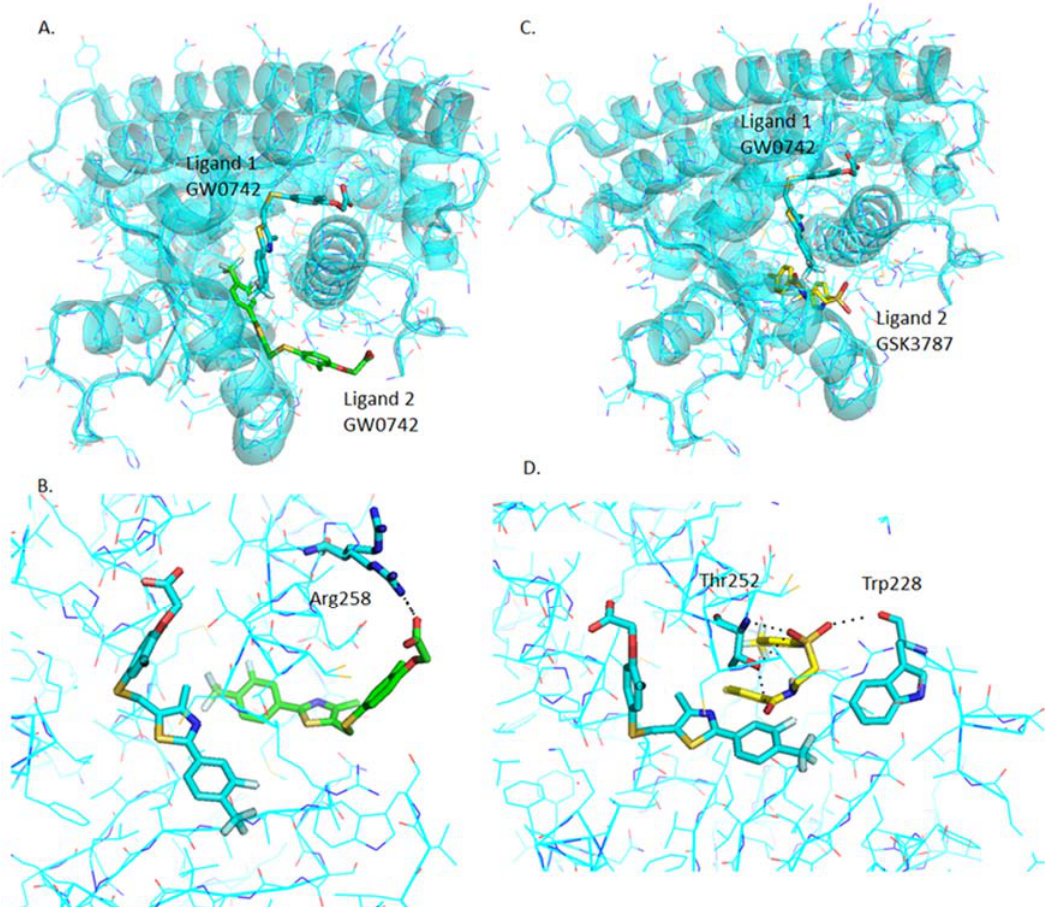
Figure 7. Analysis of GW0742 and GSK3787 docked into PPAR β / δ + GW0742. A second molecule of GW0742 ( A , B ) or GSK3787 ( C , D ) was docked into the LBD of PPAR β / δ containing one molecule of GW0742. ( A ) Representation of how two GW0742 molecules bind into the PPAR β / δ binding pocket at same time. ( B ) Detail of the amino acids interacting with the second molecule of GW0742. ( C ) Representation of how one molecule of GW0742 first and then one molecule of GSK3787 bind into the PPAR β / δ binding pocket at same time. ( D ) Detail of the amino acids interacting with the second molecule of GSK3787. Colour coding of atoms: red O, blue N, mustard S, white F, cyan C, PPAR β / δ and GW0742 that binds first within the binding pocket, green C of GW0742 that binds second into the binding pocket, yellow C of GSK3787 that binds second into the binding